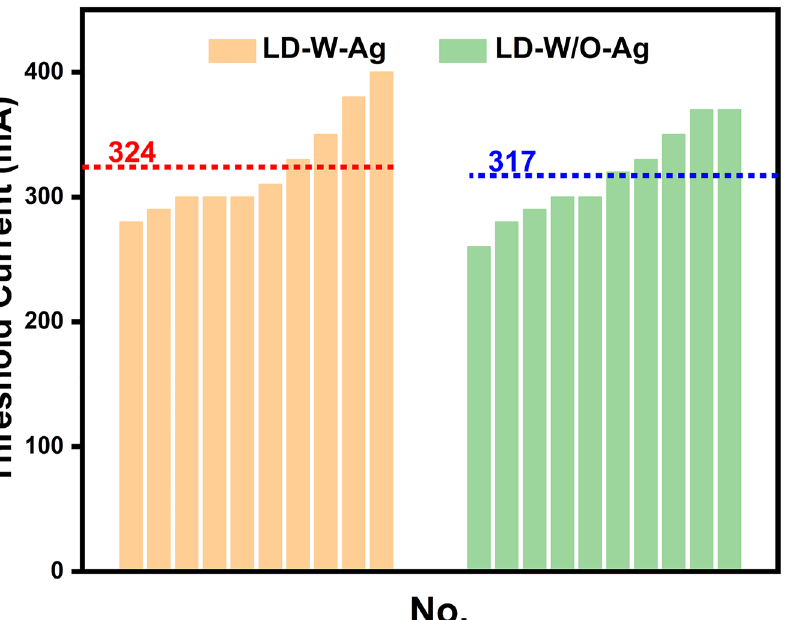
Figure 5: Threshold currents of LD-W-Ag and LD-W/O-Ag ( R = 50 μ m, r = 30 μ m). The dot lines mean the average threshold currents of LD-W-Ag and